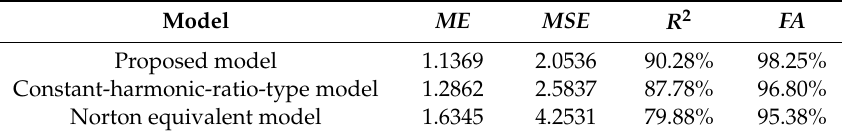
Table 5. Comparison results of the di ff erent